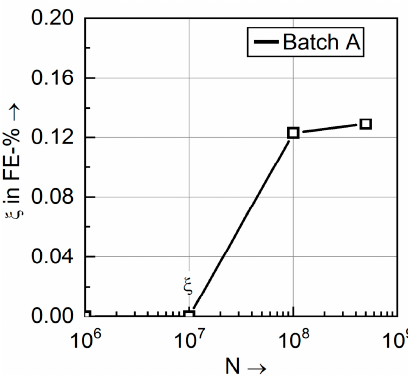
Figure 11. Development of α ’-martensite during the interrupted VHCF test at σ a = 160 MPa, f = 980 Hz and T = 300 °C.